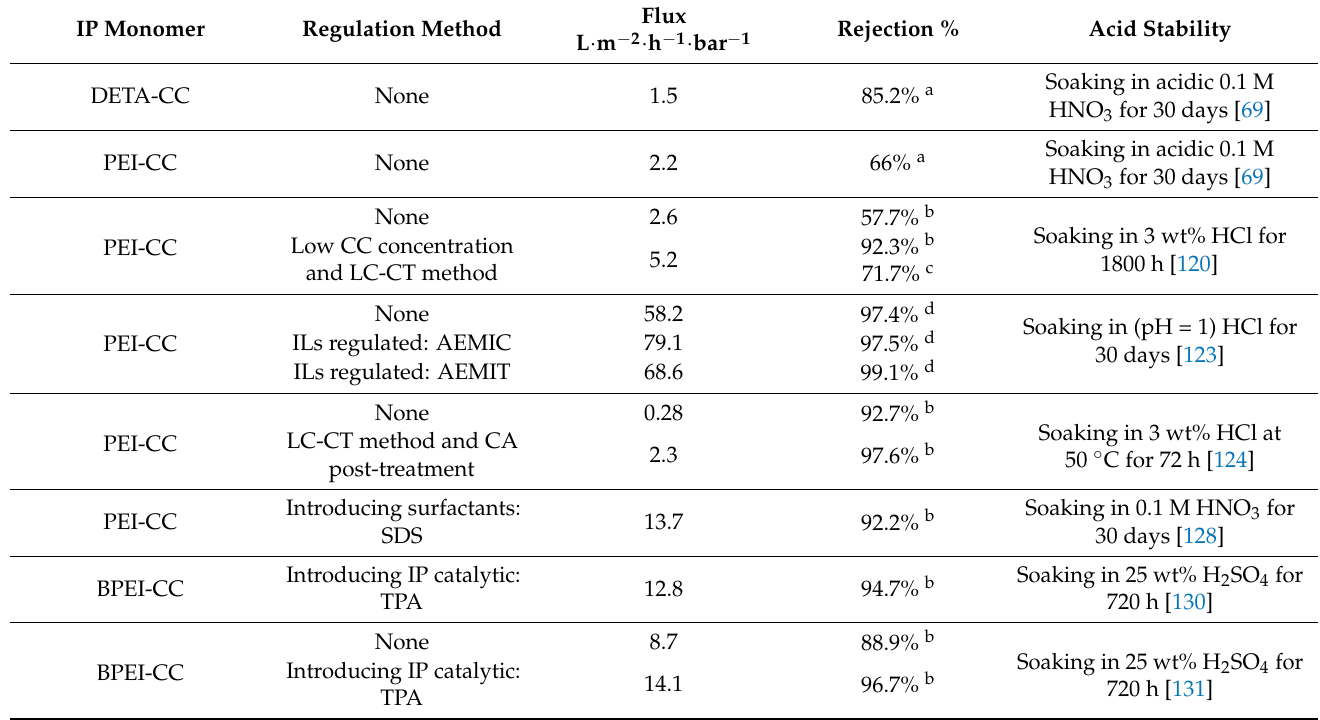
Table 3. Regulation method and acid stability of triazine polyamine NF